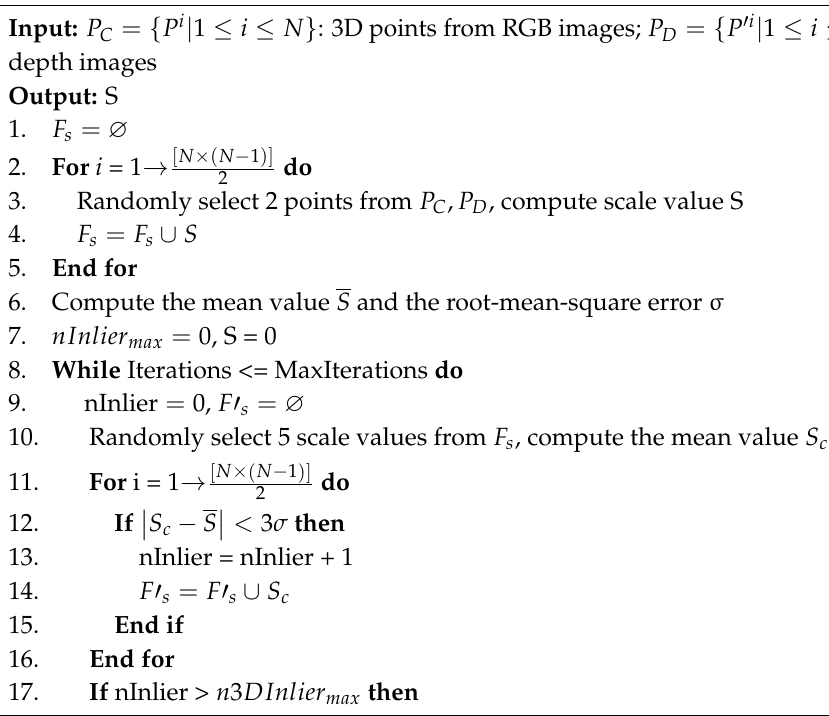
Algorithm 2 Global Scale Recovery for RGB images + Pau Ta Norm and